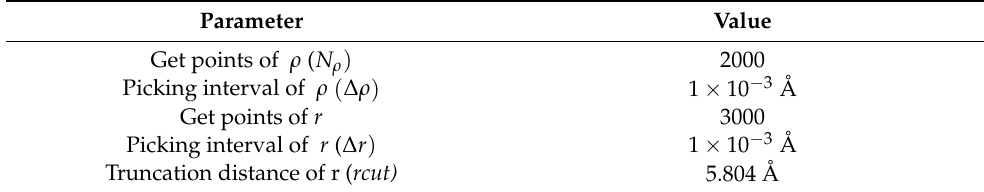
Table 1. Parameters in EAM potential functions